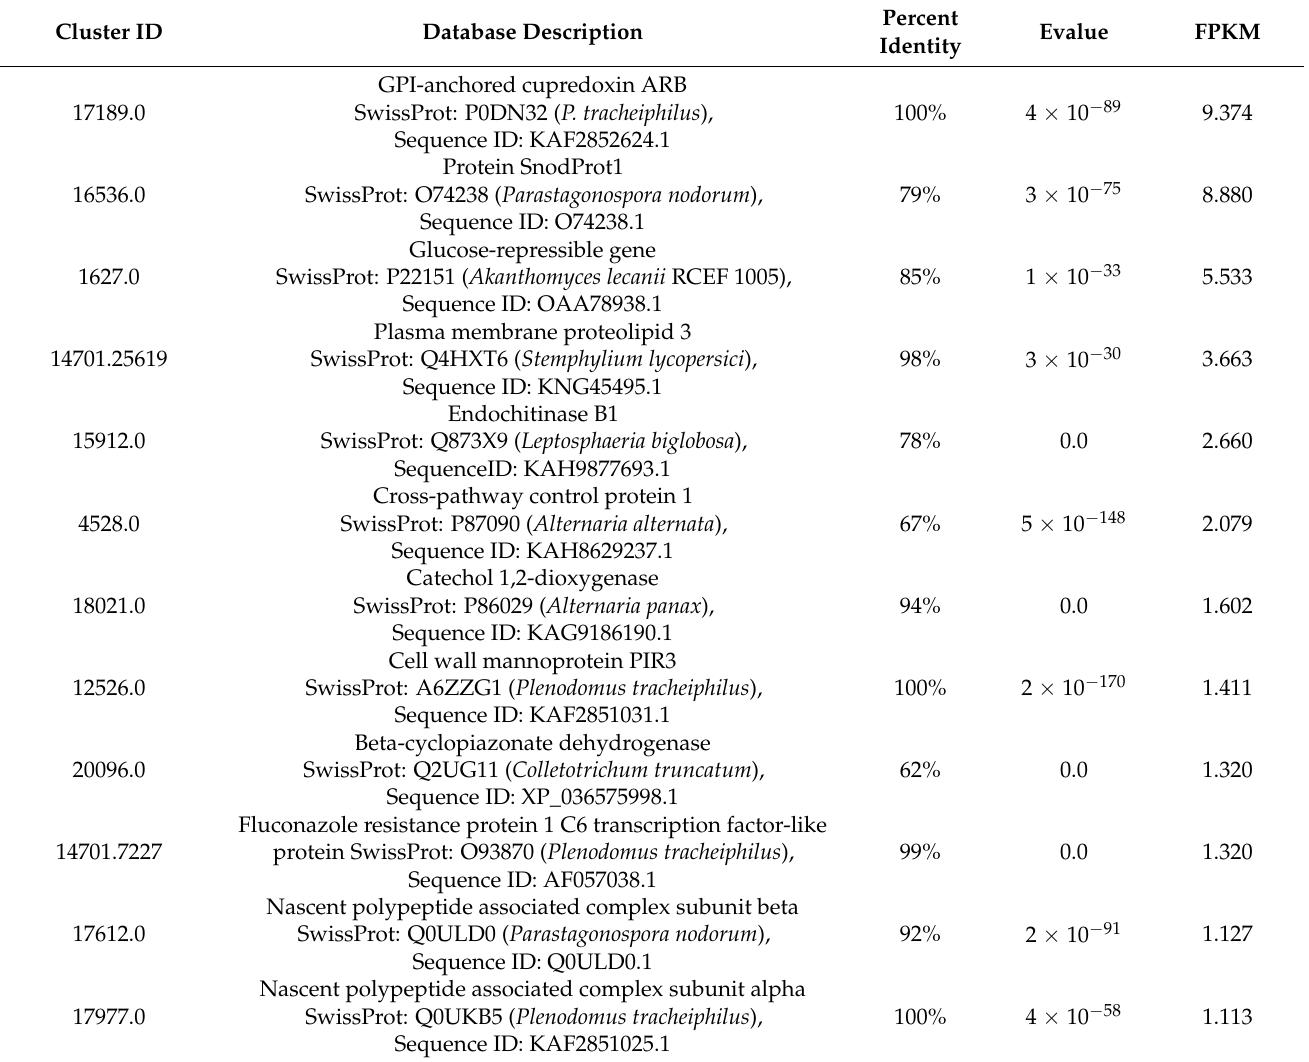
Table 1. Outlier fungus transcripts expressed during rough lemon